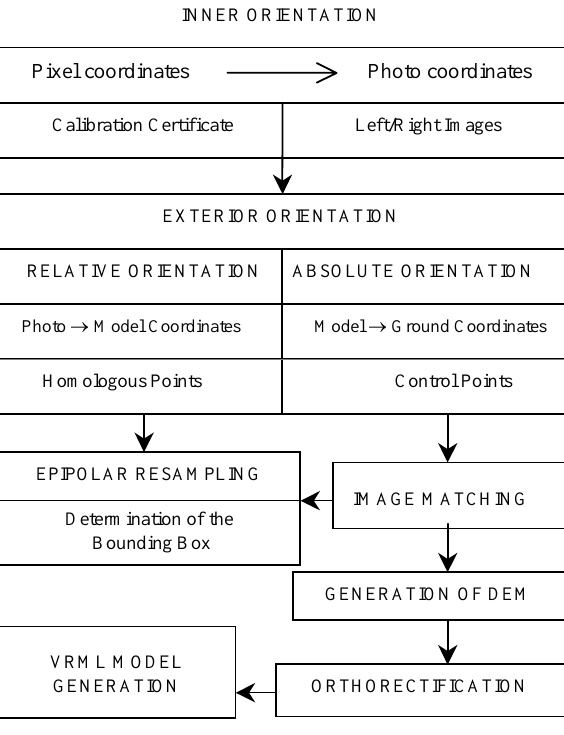
Fig 2. General workflow in DDPS